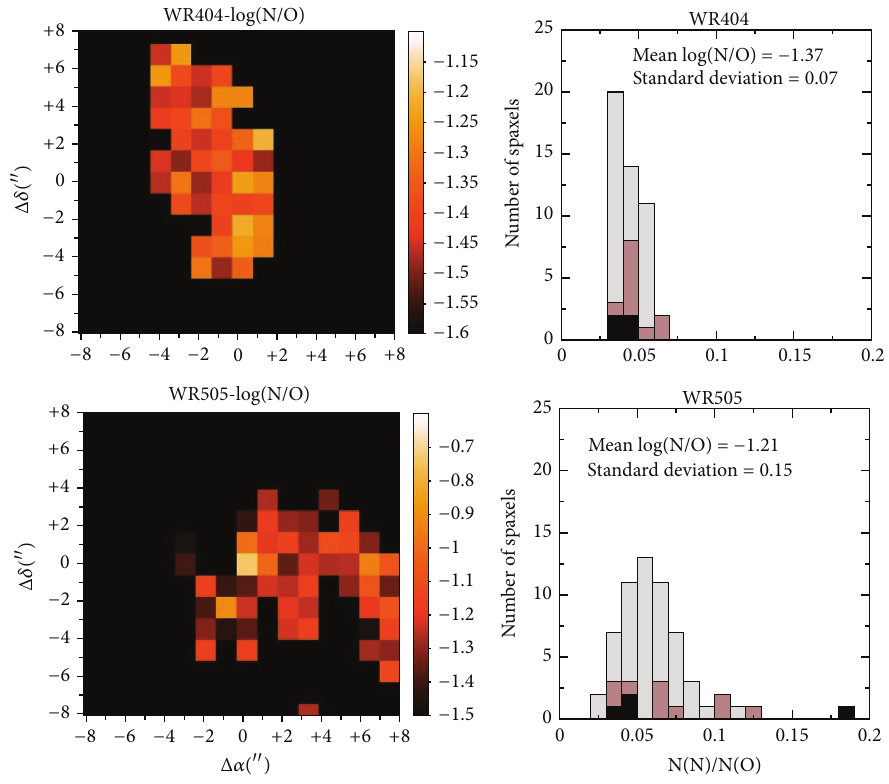
Figure 4: N/O ratio maps derived as described in the text and histogram distributions in linear scale for WR038, WR039, and WR057. In all images, each spaxel has 1 󸀠󸀠 resolution, north is up, and east is left. The colors in the bars have the same meaning as in Figure 3. Same figure for WR266, WR404, and WR505.